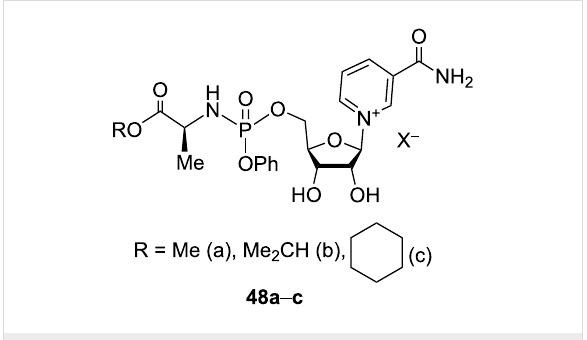
Figure 10: Structural formulas of 5 ′ -phosphorylated derivatives of NR +